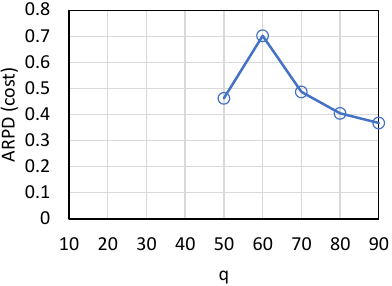
Figure 10. ARPD corresponding to Figure 9.